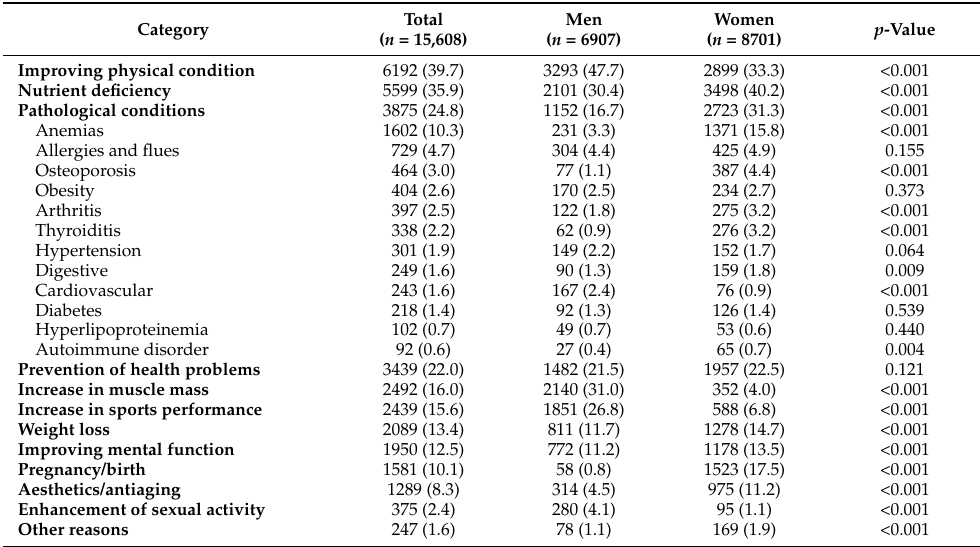
Table 5. Absolute and relative frequencies in parenthesis (%) of the reasons for DS use overall and according to sex. The p -values of chi-square tests are